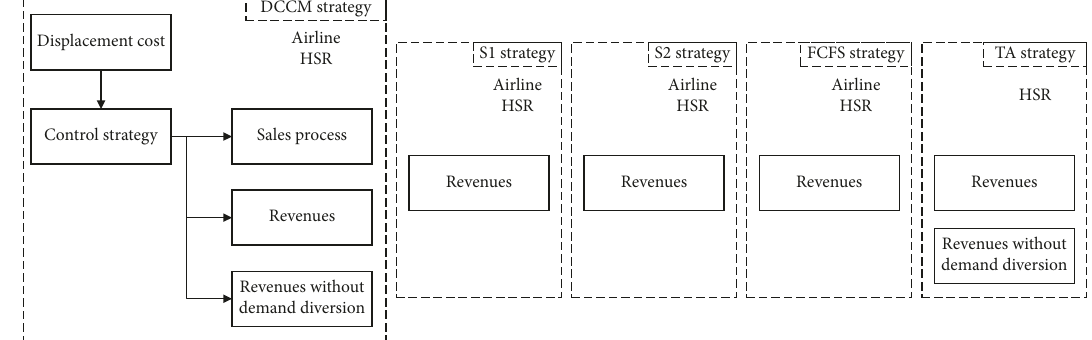
Figure 6: Result analysis framework.